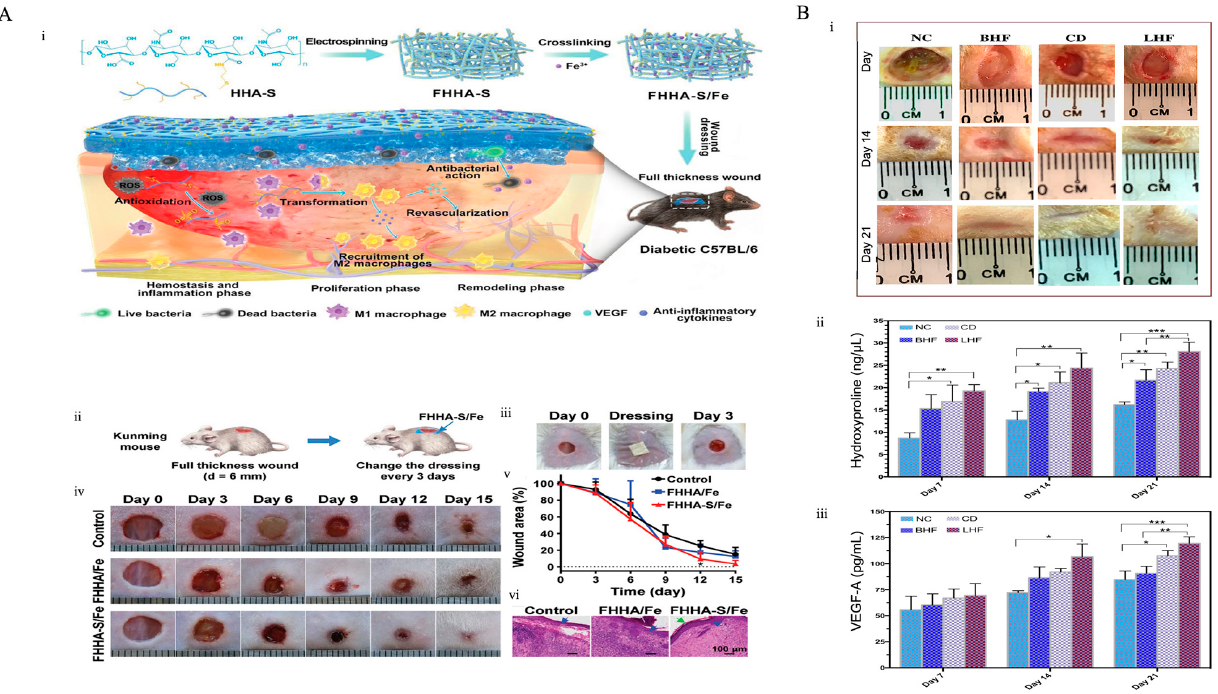
Figure 8. ( A ) Representation of hyaluronic acid nanofibrous hydrogel which grafted with thioether used for diabetic wound healing, (i) preparation of FHHA-s/Fe, dressing of hydrogel in diabetic mouse, action of mechanism of FHHA-s/Fe for chronic wound healing. (ii–vi) On an acute wound model, the FHHA-S/Fe nanofibrous hydrogel improved the healing. (ii) ( A ) The conceptual design and treatment of an acute wound. (iii) Display of Day 0 of the wound on the mouse, dressing with nanofiber, day 3 after treatment. (iv) Images of wounds following various treatments at the given days. (v) Quantitative results of the comparison of the initial wound with the indicated days. (vi) Pictures of the H&E-stained wound tissues at day 15. Reprinted with permission from [148], copy- right 2020 Wiley. ( B ) Simvastatin loaded Alginate-Pectin hydrogel for treatment of diabetic wound. (i) Wound healing rate under various conditions. (ii) On days 7, 14, and 21, the levels of hydroxy- proline various treatment cohort. (iii) The levels of VEGF-A in various treatment cohorts on days 7, 14, and 21. Values represent the mean ± SD, n = 6, * p < 0.05, ** p < 0.01, and *** p < 0.001. SD: standard deviation. Reprinted with permission from [149], copyright 2021 Elsevier. 4.8. Pectin Pectin, one of many other natural polymers in nature, is frequently used in wound healing and tissue-engineering applications with its biocompatible and biodegradable properties [150]. Pectin—a heteropolysaccharide—has significant residues such as D- galacturonic acid (GalpA) in its chain structure. A key factor in controlling the solubility of pectin as well as its gelling and film-forming capabilities is the degree of esterification (D.E.) of these galacturonic acid residues. The controllability and modifiability of these polymers make them a crucial tool for tissue engineering studies [151]. For instance, Rez- vanian et al. fabricated a simvastatin-loaded alginate-pectin hydrogel film for diabetic wound healing [149] (Figure 8B). They emphasized the importance of simvastatin by com- paring this hydrogel film with a commercial dressing and blank hydrogel. Consequently, simvastatin-loaded hydrogel demonstrated a ~95% wound healing rate, whereas the simvastatin-free hydrogel and commercial dressing provided ~80% efficiency in 21 days. As seen in this study, natural polymers can be used in combination with many other nat- ural polymers. In another study, Hasan et al. produced a hydrogel by combining pectin with alginate and hyaluronic acid and loaded clindamycin on this hydrogel [152]. Clindamycin (Cly)-loaded hydrogel was employed for the treatment of methicillin-re- sistant Staphylococcus aureus (MRSA)-infected wounds. Clindamycin was employed for its